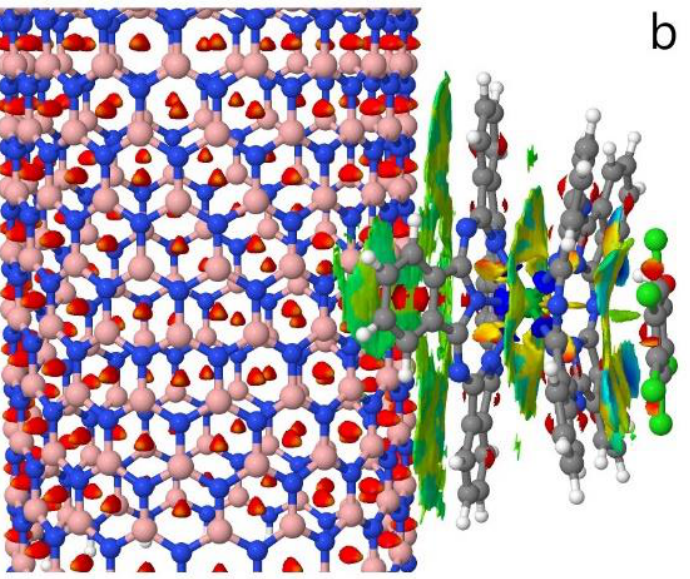
Figure 1. Non-covalent interaction between pentachlorophenol (pcp) and zigzag ( a ) (9,0) and ( b ) (18,0) boron nitride nanotubes decorated with YbPc 2 complex.